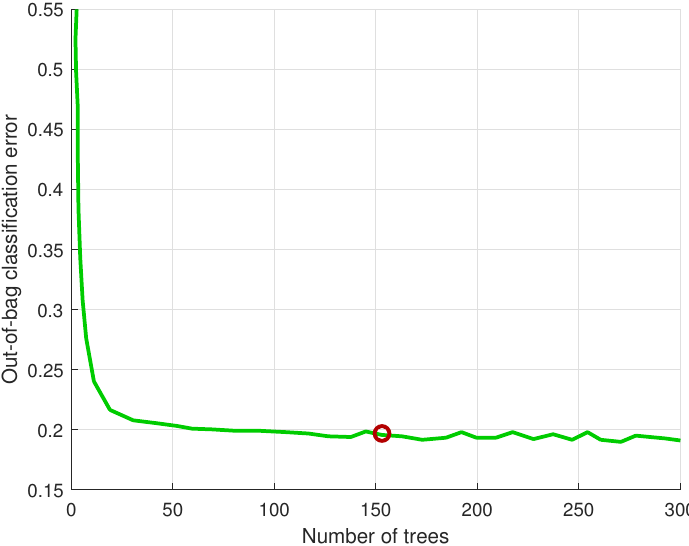
Figure 8. Sensitivity analysis on the number of trees in the RF with time horizon equal to 5 min.